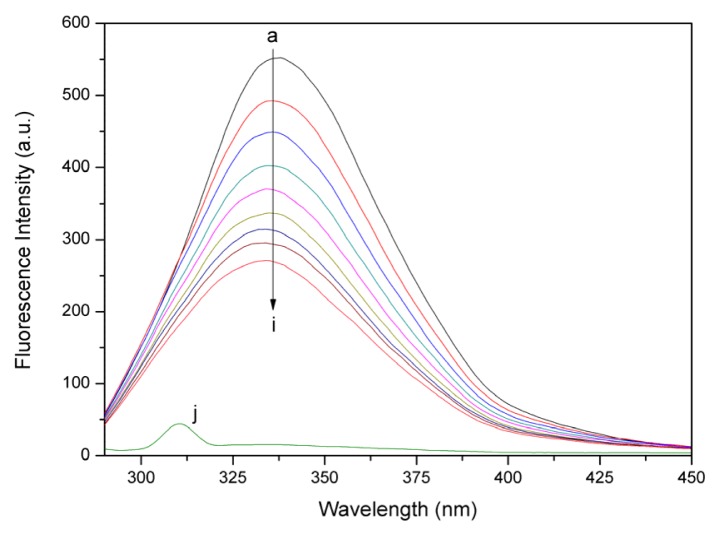
Fluorescence spectra of BSA with various amounts of eupatorin (pH 7.4, 298 K). (a) 3.0 × 10−7 M BSA; (b–i) 3.0 × 10−7 M BSA in the presence of 2.0, 4.0, 6.0, 8.0, 10.0, 12.0, 14.0, and 16.0 × 10−7 M eupatorin; (j) 15.0 × 10−7 M eupatorin; λex = 280 nm, λem = 290–500 nm.